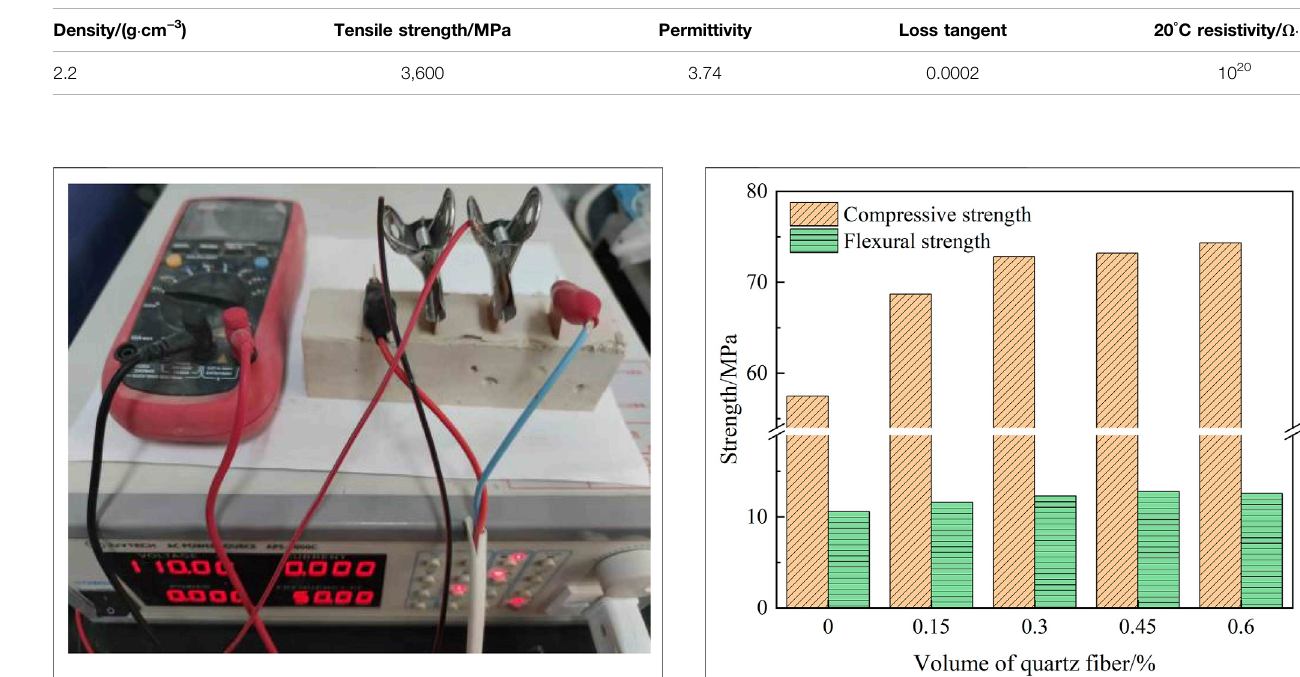
FIGURE 1 | The device for testing resistivity.